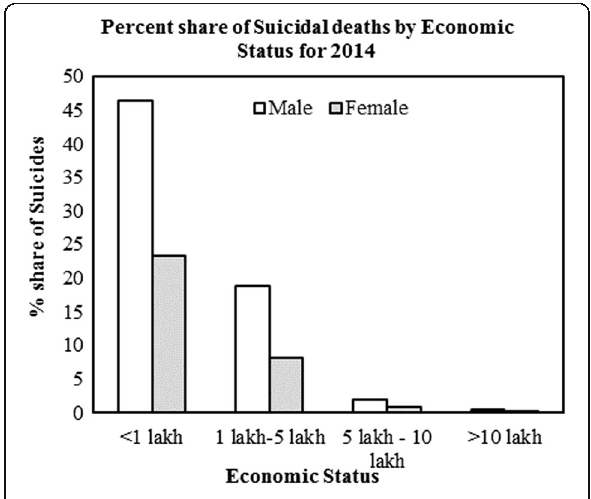
Fig. 3 a . Age-group wise percent share of Suicidal deaths for year 2013. b . Age-group wise percent share of Suicidal deaths for year 2014